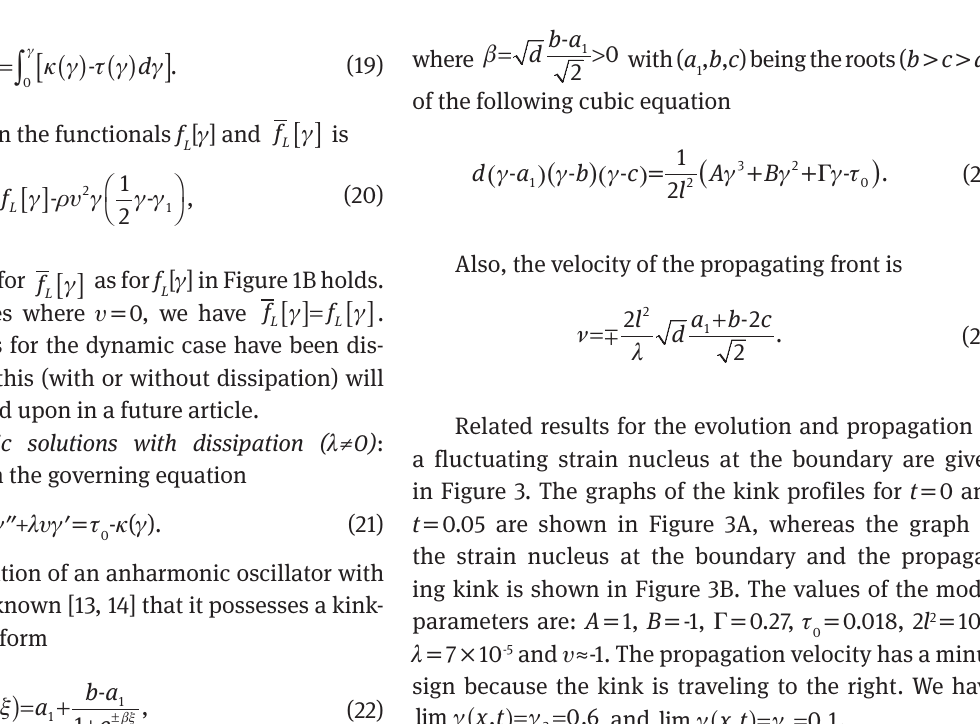
> with ( a , b , c ) being the roots ( b > c > a 1